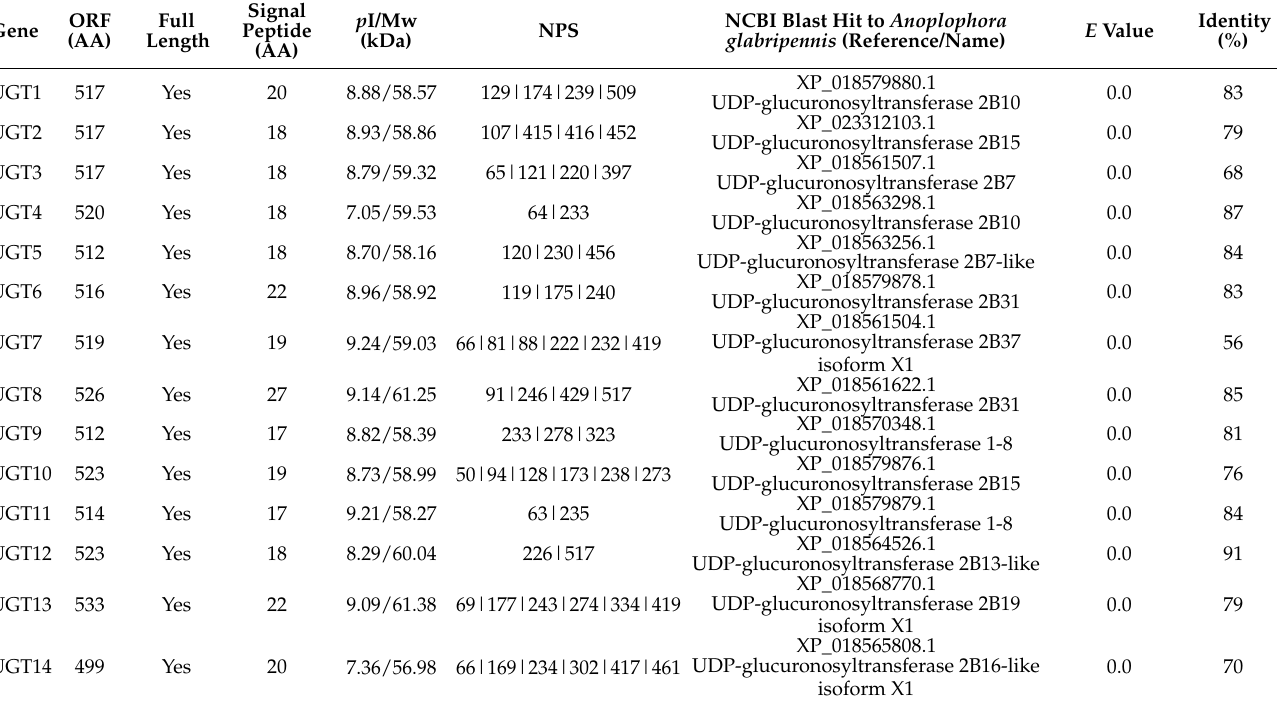
Table 1. The information for candidate PantUGT genes of P. antennata